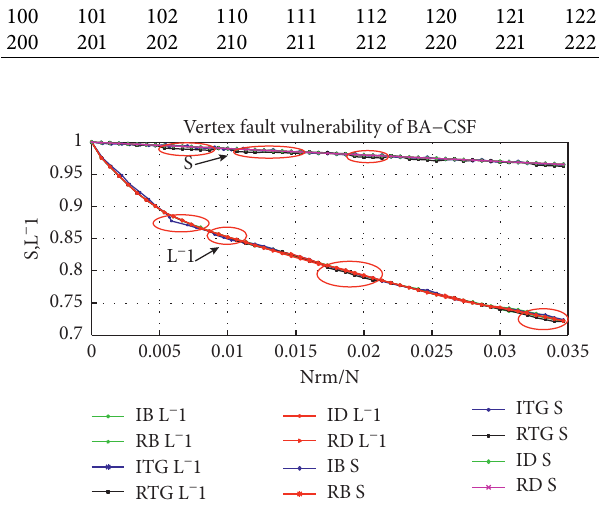
Figure 3: l − 1 & S result of BACSF.